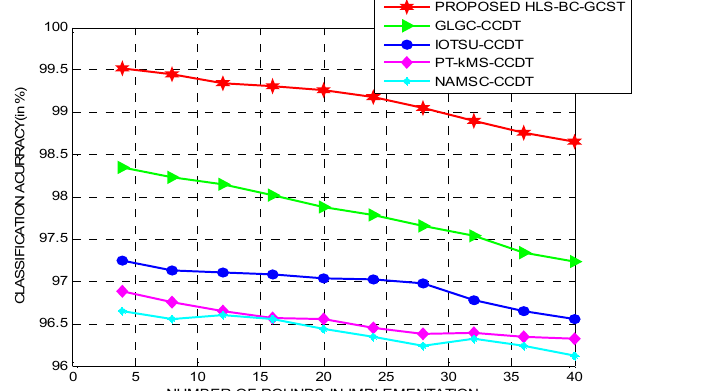
Figure 3. Representation of graph cut.